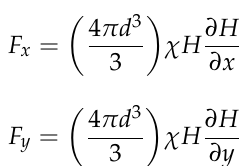
Table 2. Equipment performance parameters.